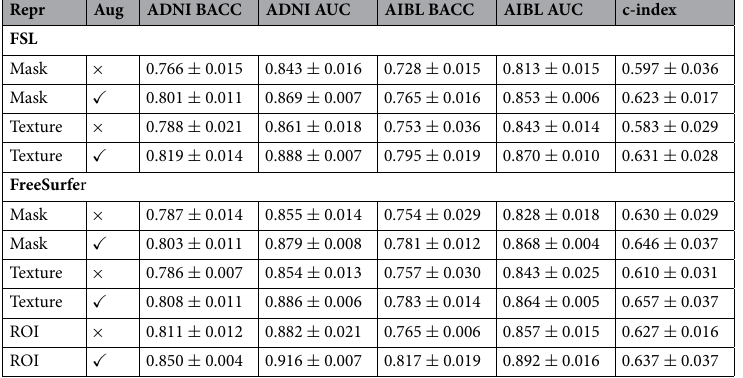
Table 3. Effect of augmentation for volumetric representations (BACC: balanced accuracy, AUC: Area under the ROC curve) on ADNI and AIBL, as well as, the concordance index (c-index) for